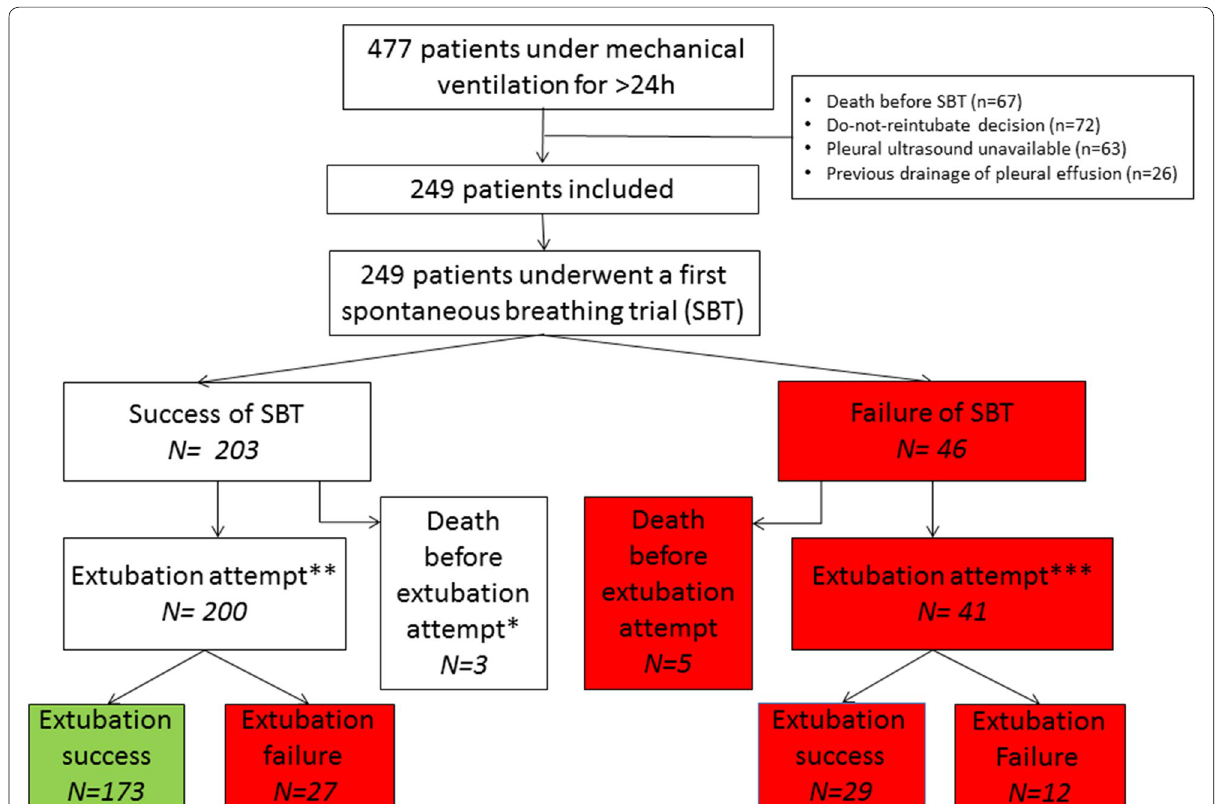
Fig. 1 Study flow chart; green and red squares denote International Consensus Conference classification of weaning success and failure, respectively; *three patients were not extubated despite the success of the first SBT because of borderline cough, and experienced a novel fatal complication leading to death before any extubation attempt; they could not be classified according to the International Consensus Conference **including 192 planned and 7 unplanned. *** Including 39 planned and 2